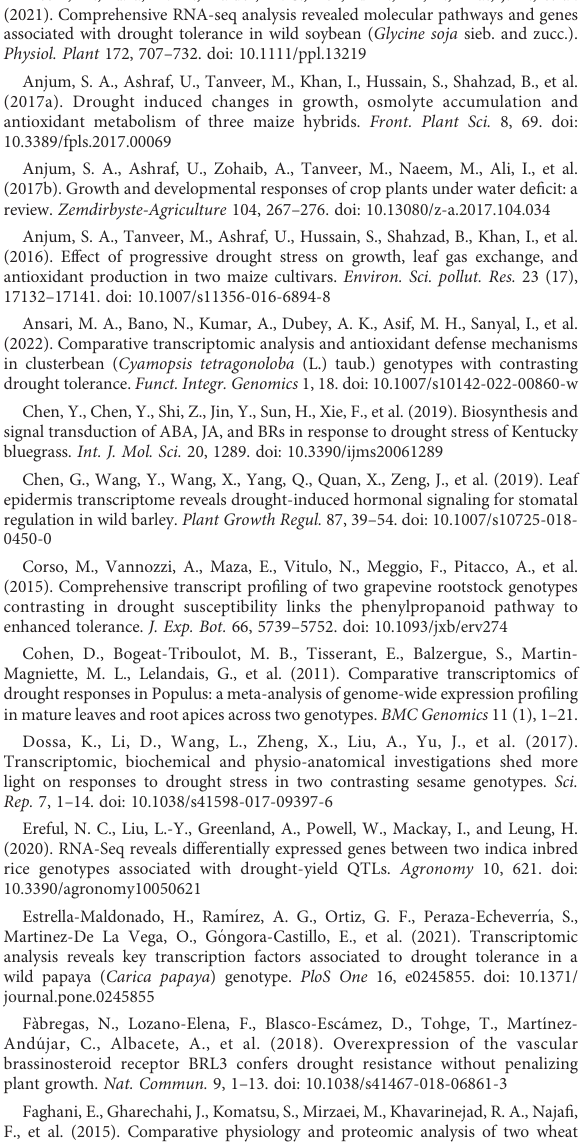
SUPPLEMENTARY FIGURE 3 The expression numbers of transcriptomic responses in each treatment using a PCA, three peak lines showing variations in the analysis values.